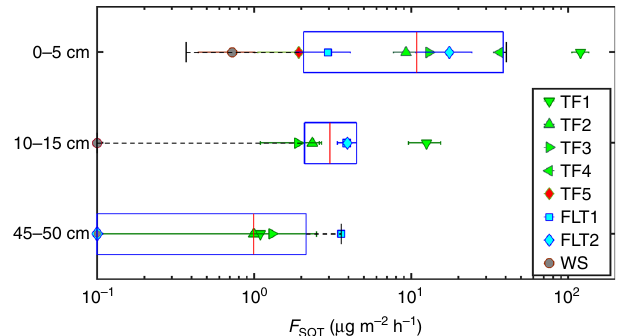
Fig. 2 Depth pro fi le of optimum SQT emissions. Plotted are SQT fl ux optimum from all experiments (excluded the points for anaerobic conditions for 0 – 5 cm; S5, S8, S11, S12) as a function of depth (horizontal box and whisker plots). The markers indicate the values of individual Pits denoted in the fi gure ’ s legend. The error bar of each marker indicates the standard deviation of replicates (see Supplementary Table 1). SQT the FLT. Soils that were collected from the middle horizon (10 – 15 cm) were insigni fi cantly stronger than the bottom soils, apart from